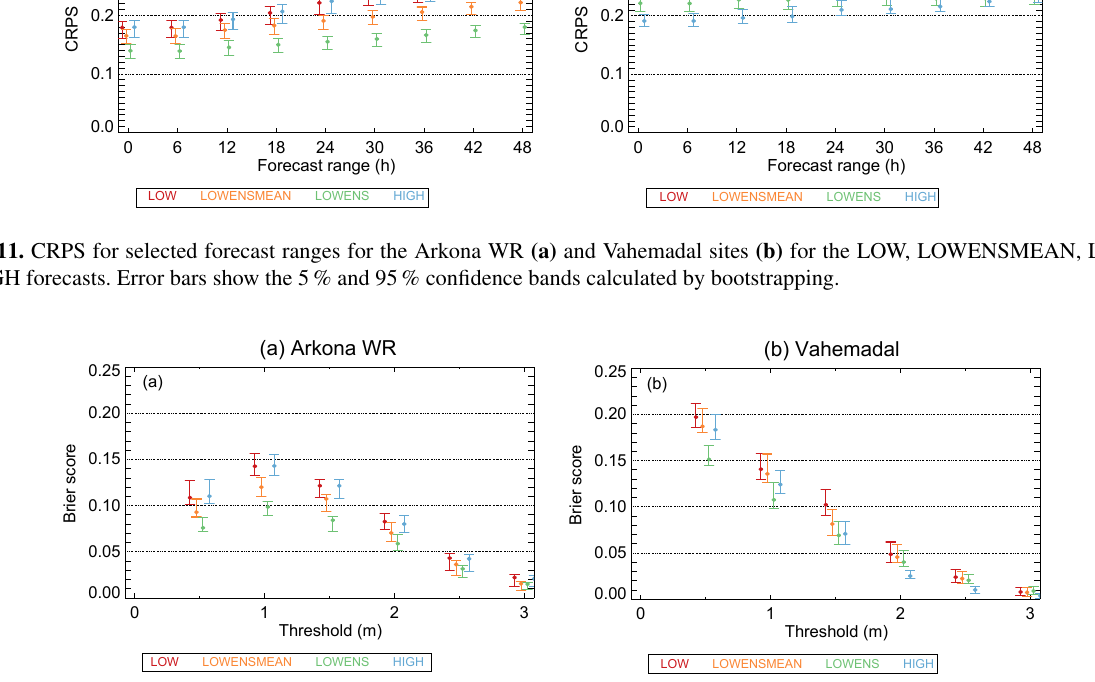
Figure 12. Brier score for the Arkona WR (a) and Vahemadal sites (b) for binary forecasts for a forecast range of